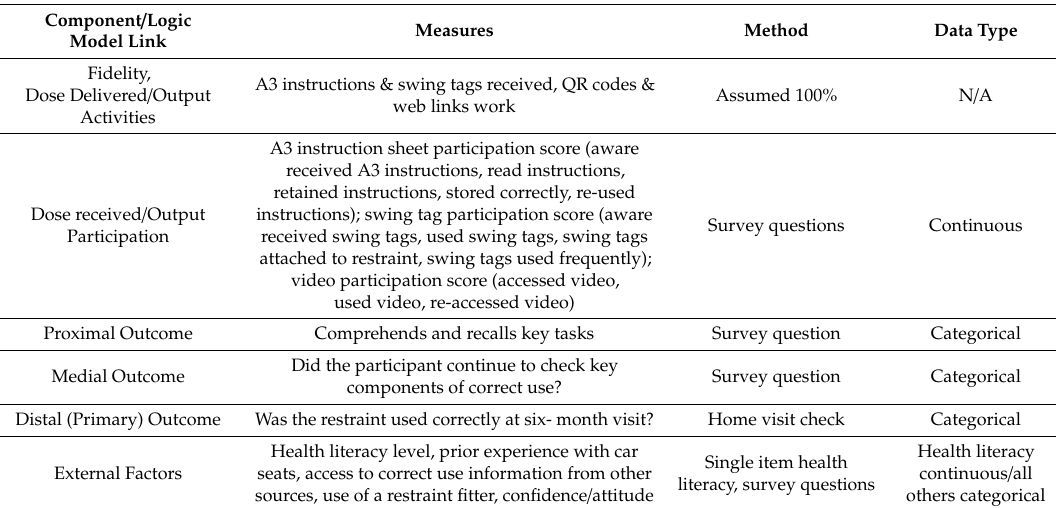
Table 1. Process